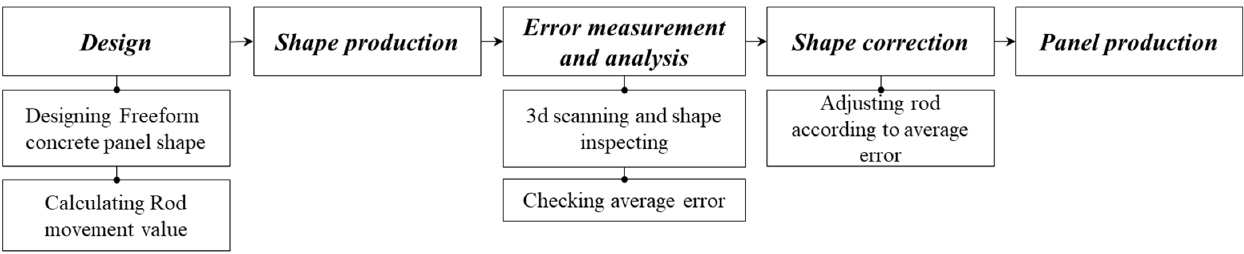
Figure 9. Operational technology for freeform concrete panel